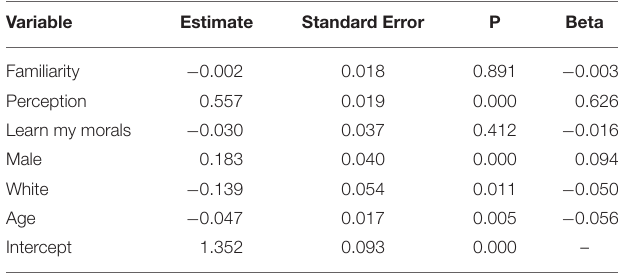
TABLE 3 | Predicting willingness to adopt